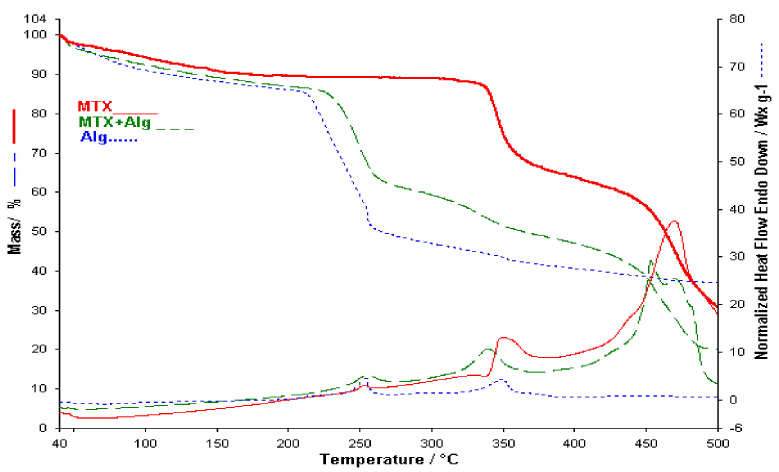
Figure 5. TGA/HF curves for MTX, Alg and Binary